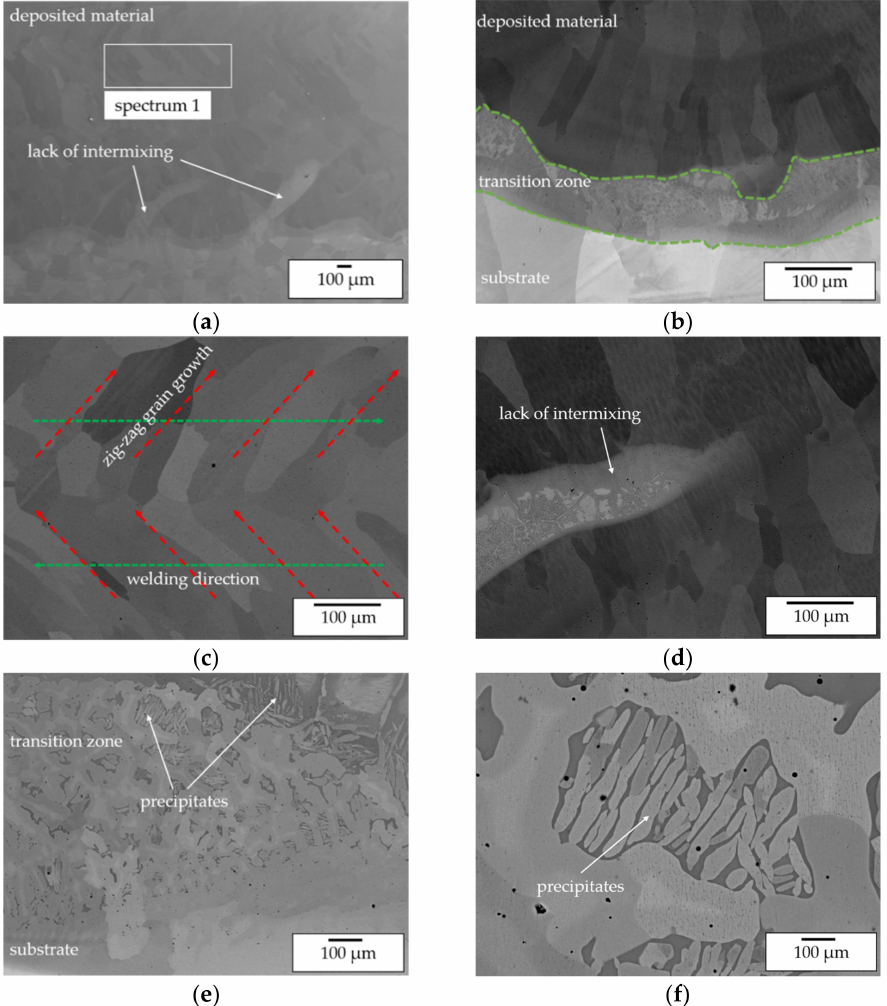
Figure 20. SEM BEC images of a cuboid specimen manufactured with pre-alloyed powder at 1100 ◦ C pre-heating temperature—( a ) overview showing transition from Ni substrate to the deposited single phase β -NiAl material; ( b ) Ni-NiAl transition zone at 200 × magnification; ( c ) zig-zag grain structure of the deposited single phase β -NiAl material; ( d ) lack of intermixing causing multi-phase Ni-rich regions; ( e ) transition zone at 1000 × magnification; ( f ) transition zone at 500 × magnification showing the formation of precipitates.